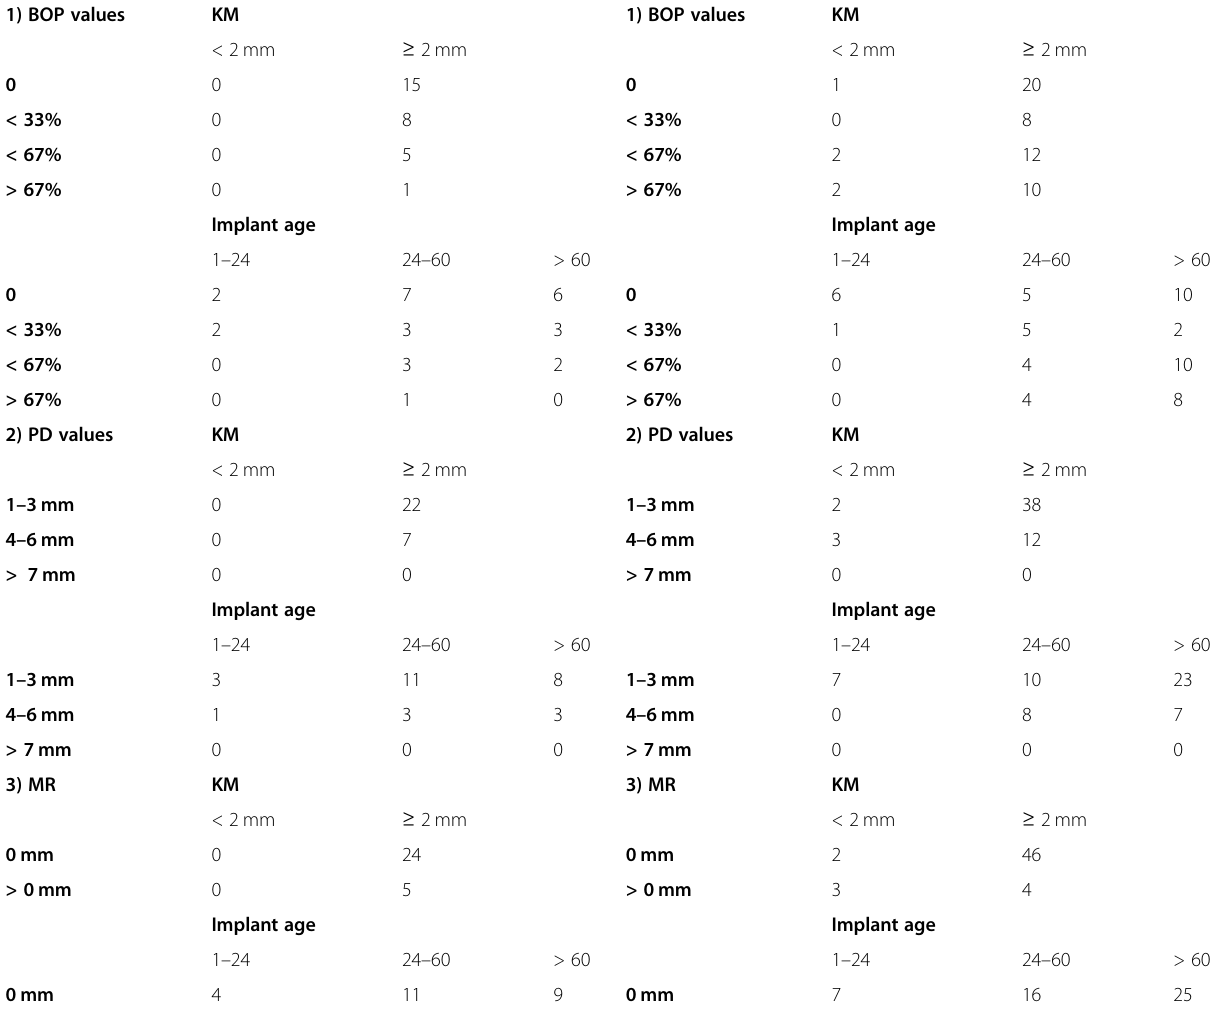
Table 5 Test group ( n = 29 implants). Cross-tables of BOP/PD/ MR values and (1) KM and (2) implant age (months)